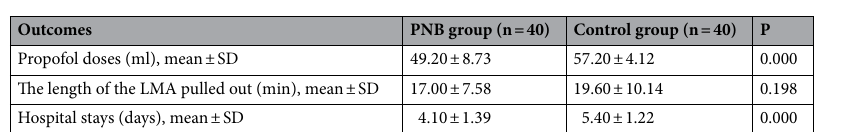
Table 2. Perioperative outcomes of the patients in the two groups. PNB phrenic nerve block, SD standard deviation.